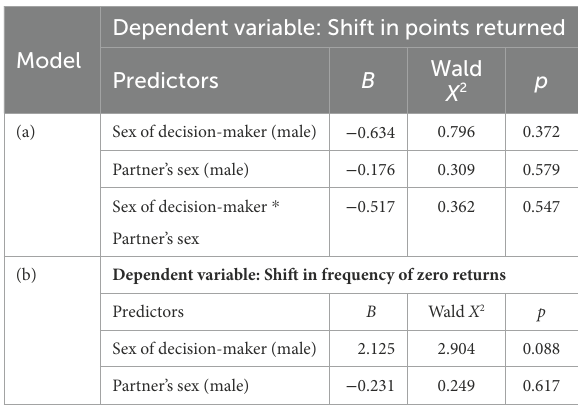
FIGURE A1 Distributions of decisions in trustworthiness part of the Trust Game. Relative frequencies (per participants’ sex) of decisions in the trustworthiness part of the Trust Game under three experimental conditions: Anon, anonymous interactions; Pers SS, personalized same-sex interactions; Pers OS, personalized opposite-sex interactions. X -axis represents amounts of points returned to a partner. TABLE A1 Sex-related shifts in trustworthiness.